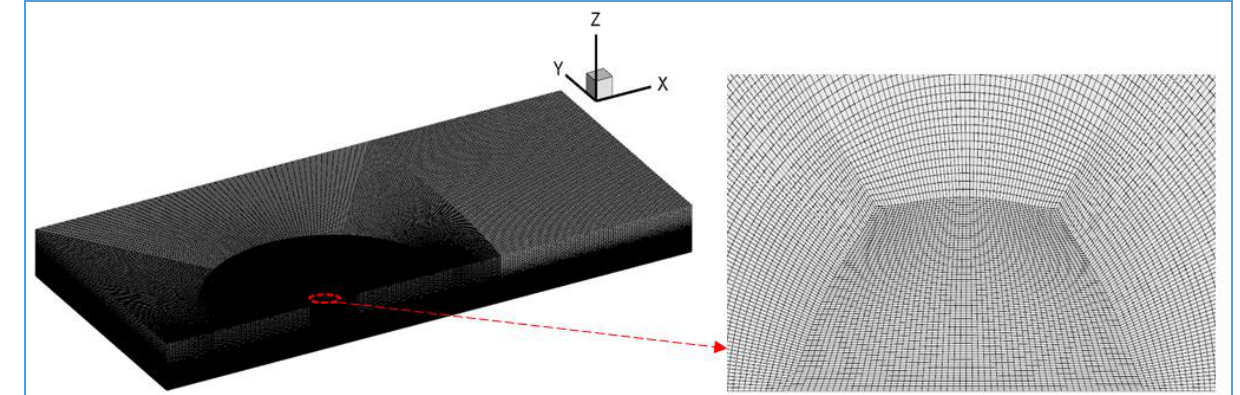
Figure 2. Schematic diagram of the grid demarcation. The CFD software ANSYS FLUENT 15.0 was employed for numerical simulation.